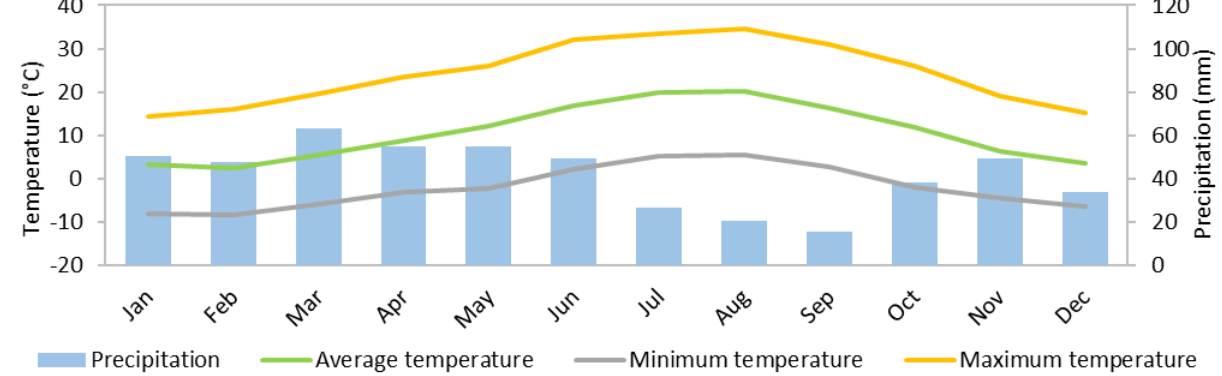
Figure A2. Average monthly climatic conditions of the study site located in Spain during the study period 2009 – 2018.